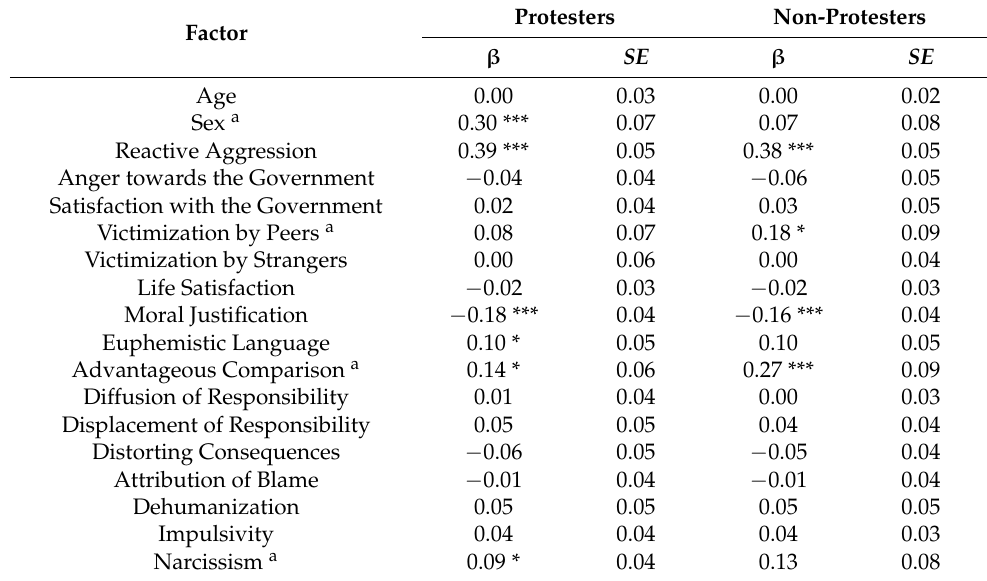
Table 10. Final Multiple Group Model Predicting Proactive